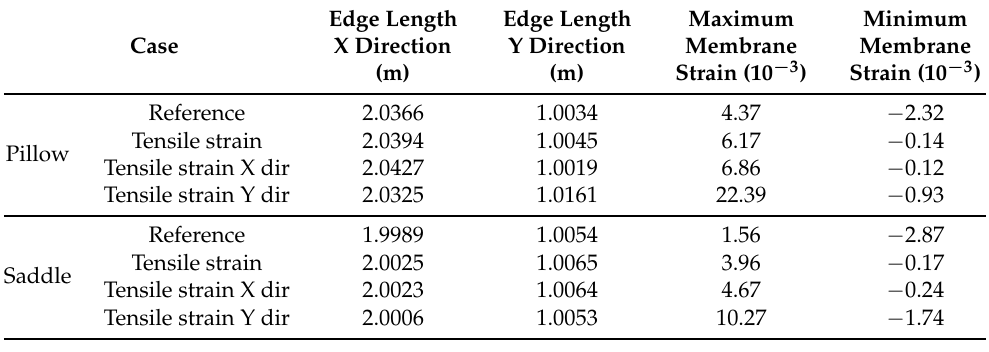
Table 2. Comparison of pillow- and saddle-shape flattening results.